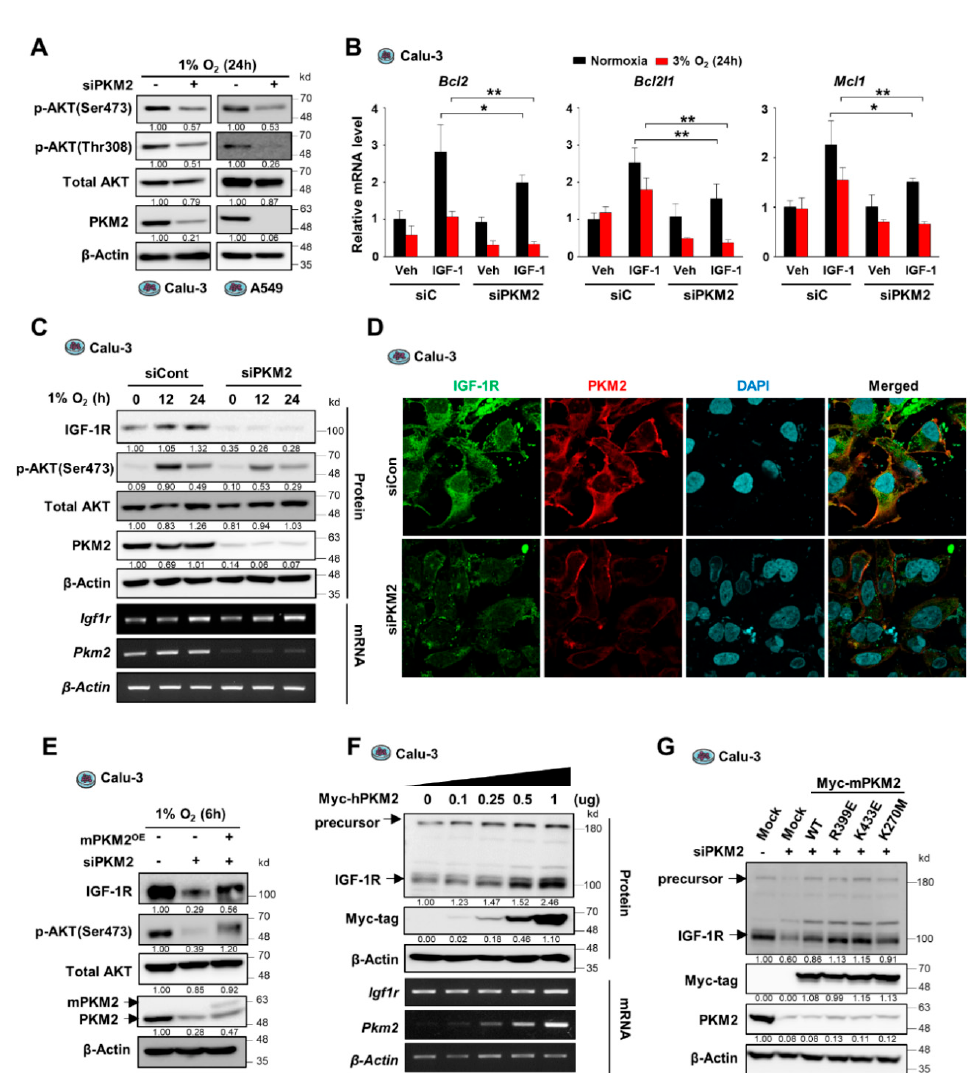
Figure 2. PKM2 deficiency reduces AKT phosphorylation by suppressing IGF-1R expression in hypoxic conditions. ( A ) Abundance of AKT and phospho-AKT proteins in Calu-3 cells transfected with control siRNA or PKM2 siRNA under hypoxic condition (1% O 2 ) for 24 h. ( B ) The levels of mRNA expression of anti-apoptotic genes in Calu-3 cells transfected with control siRNA or PKM2 siRNA under normoxic or hypoxic conditions (3% O 2 ) for 24 h, normalized to β -actin mRNA. IGF-1 (200 ng/mL) was treated for 24 h. Values of graph were presented as mean ± SD. Statistical significance was measured using one-way ANOVA with the Tukey post hoc test. * p < 0.05, ** p < 0.01. ( C ) (Upper panel) Protein abundance of IGF-1R, p-AKT(S473), PMK2, and AKT1/2; and (lower panel) mRNA expression for IGF-1R and PKM2 in Calu-3 cells transiently transfected with siPKM2 under hypoxic conditions (1% O 2 ) for indicated times. ( D ) Confocal microscopic images of endogenous IGF-1R and PKM2 detected by immunofluorescence in Calu-3 cells transfected with PKM2 siRNA under hypoxic condition (1% O 2 ) for 6 h. ( E ) IGF-1R and p-AKT(S473) protein abundance in Calu-3 cells transiently transfected with siPKM2 and/or Myc-tagged mouse PKM2 gene (Myc-mPKM2). ( F ) Protein and mRNA levels of IGF-1R in Calu-3 cells transiently transfected with different doses of Myc-tagged human PKM2 gene (Myc-hPKM2). ( G ) IGF-1R protein abundance in Calu-3 cells transiently transfected with siPKM2 and/or Myc-tagged mutant mPKM2 genes. β -Actin was used as the loading control in ( A ,C, E – G